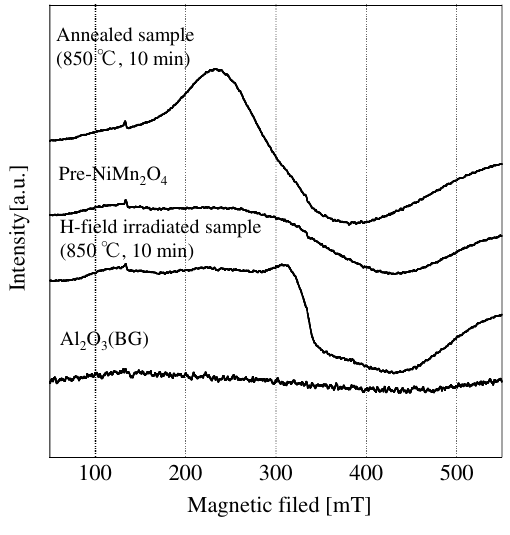
Figure 6. Electron spin resonance (ESR) spectra of NiMn 2 O 4